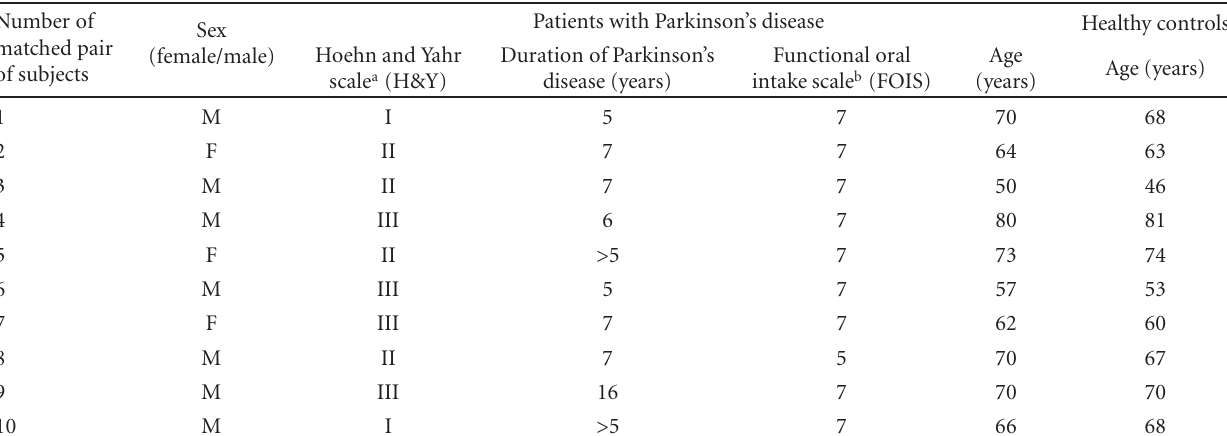
Table 1: Subject